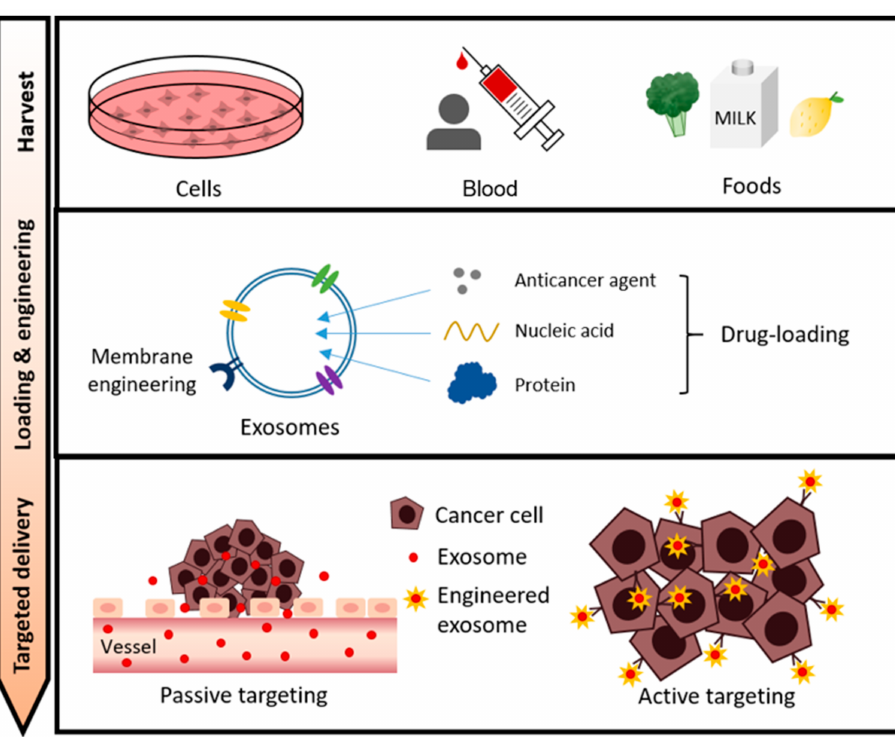
Figure 2. The overall process of exosome-based drug delivery in cancer therapy. Cell/blood/food- derived exosomes can be sources for drug delivery carriers. Exosomes loaded with therapeutic agents such as anticancer agents, nucleic acids, and proteins can be delivered to cancer cells by passive or active